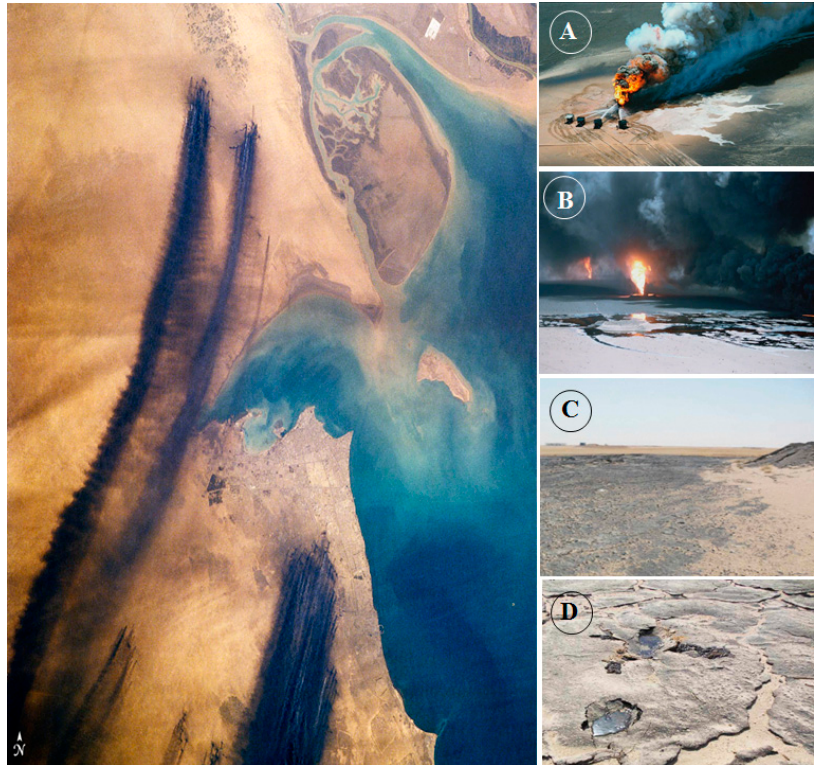
Figure 9. Landsat-TM image (courtesy of NASA) and ground photos (from web) of oil wells on fire in Kuwait during the Gulf war in 1991. Firefighting crews trying to put out the fires ( A and B ) and crusts of salt and crude oil burned postwar in 1992 ( C and D ).